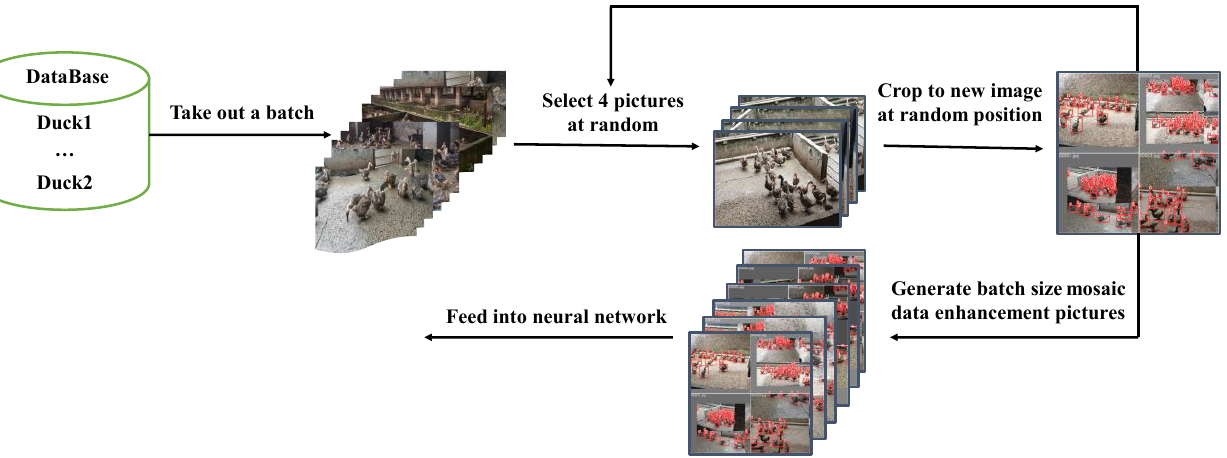
Figure 4. Mosaic data augmentation. Firstly, a batch of image data was randomly extracted from the dataset of mallard ducks. Then, four images were randomly selected, randomly scaled, randomly distributed, and spliced into new images, and the above operations were repeated for batch size times. Finally, the Mosaic data augmentation data were fed into the neural network for training.